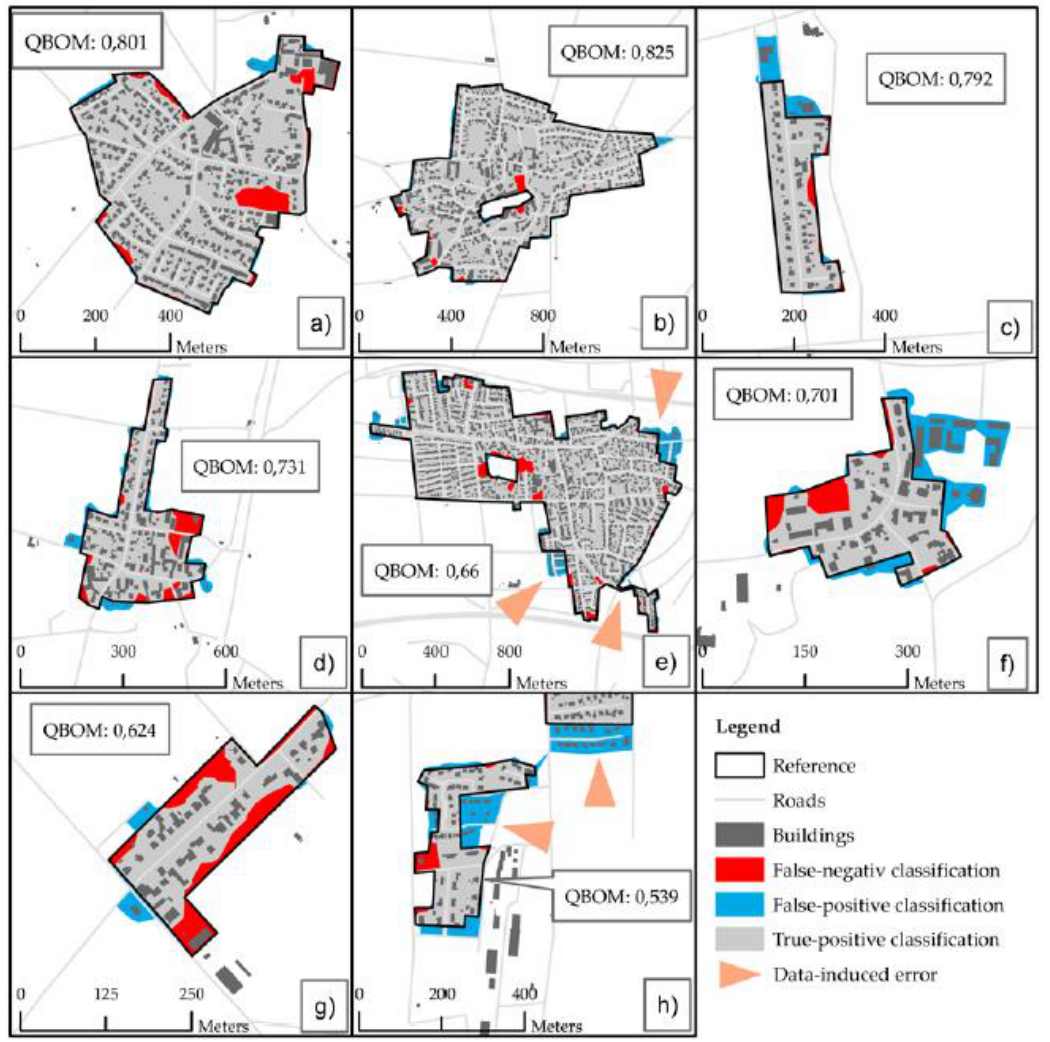
Figure 8. Examples of optimized boundaries relative to a reference, quality value Q BOM and Examples of optimized boundaries relative to a reference, quality value Q classification results of variant DPA-BRPP (Official building polygons, ATKIS ® Base-DLM © Geobasis-DE/BKG (2011)): settlement bodies of (a) Wilkenburg, (b) Jeinsen, (c) Gailhof, (d) Röddensen, (e) Godshorn, (f) Eckerde, (g ) Klein Kolshorn and (h) Wehmingen